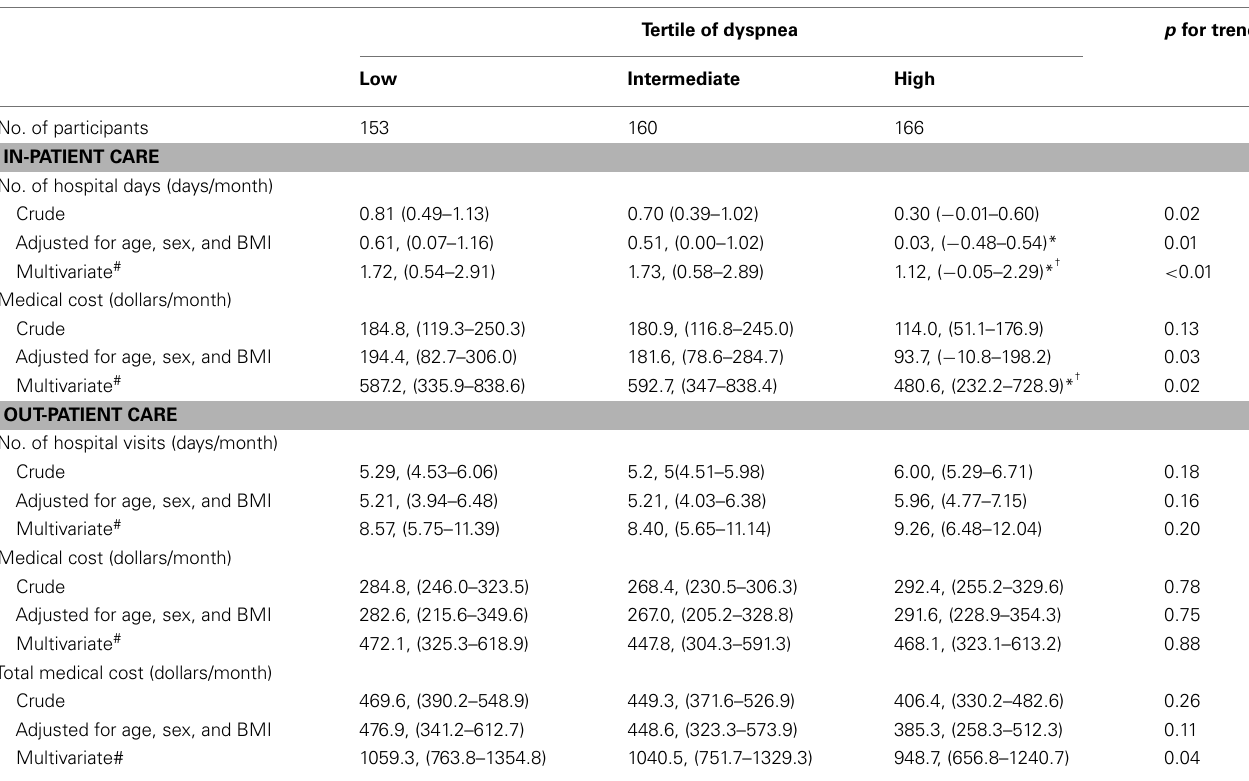
Table 2 |Adjusted medical use and costs in relation to dyspnea tertile ( n =